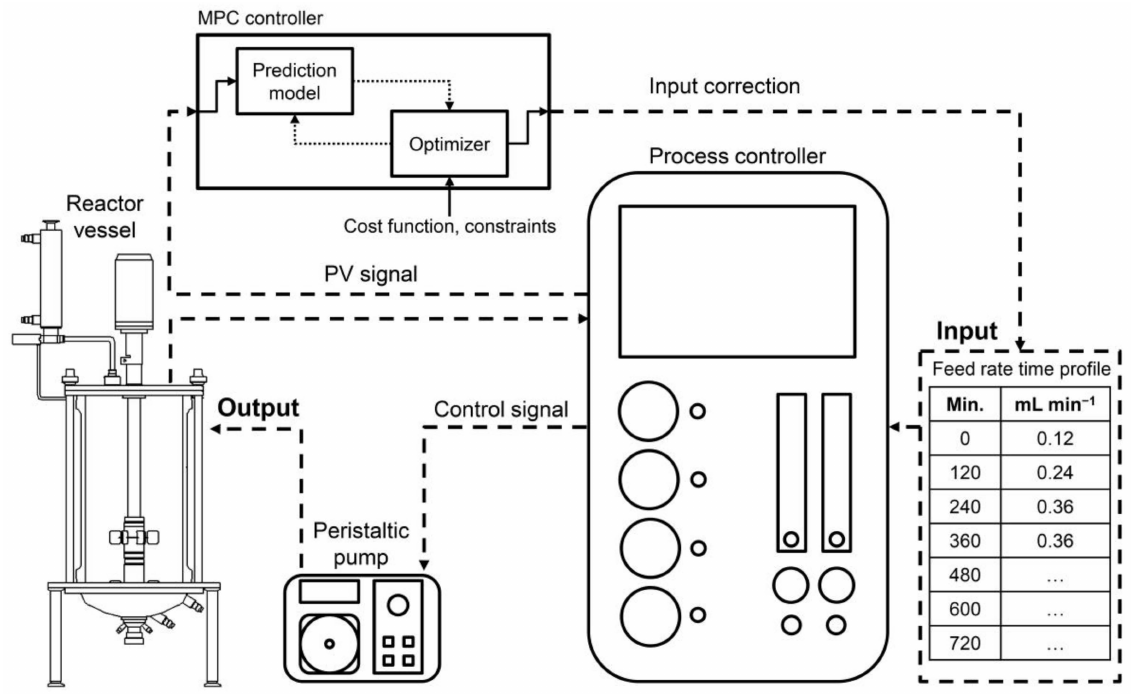
Figure 8. An example of an MPC